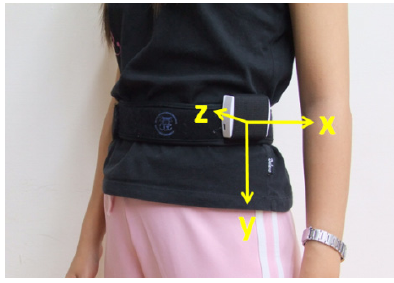
Figure 3. Wearing position and the axial direction of sensor.